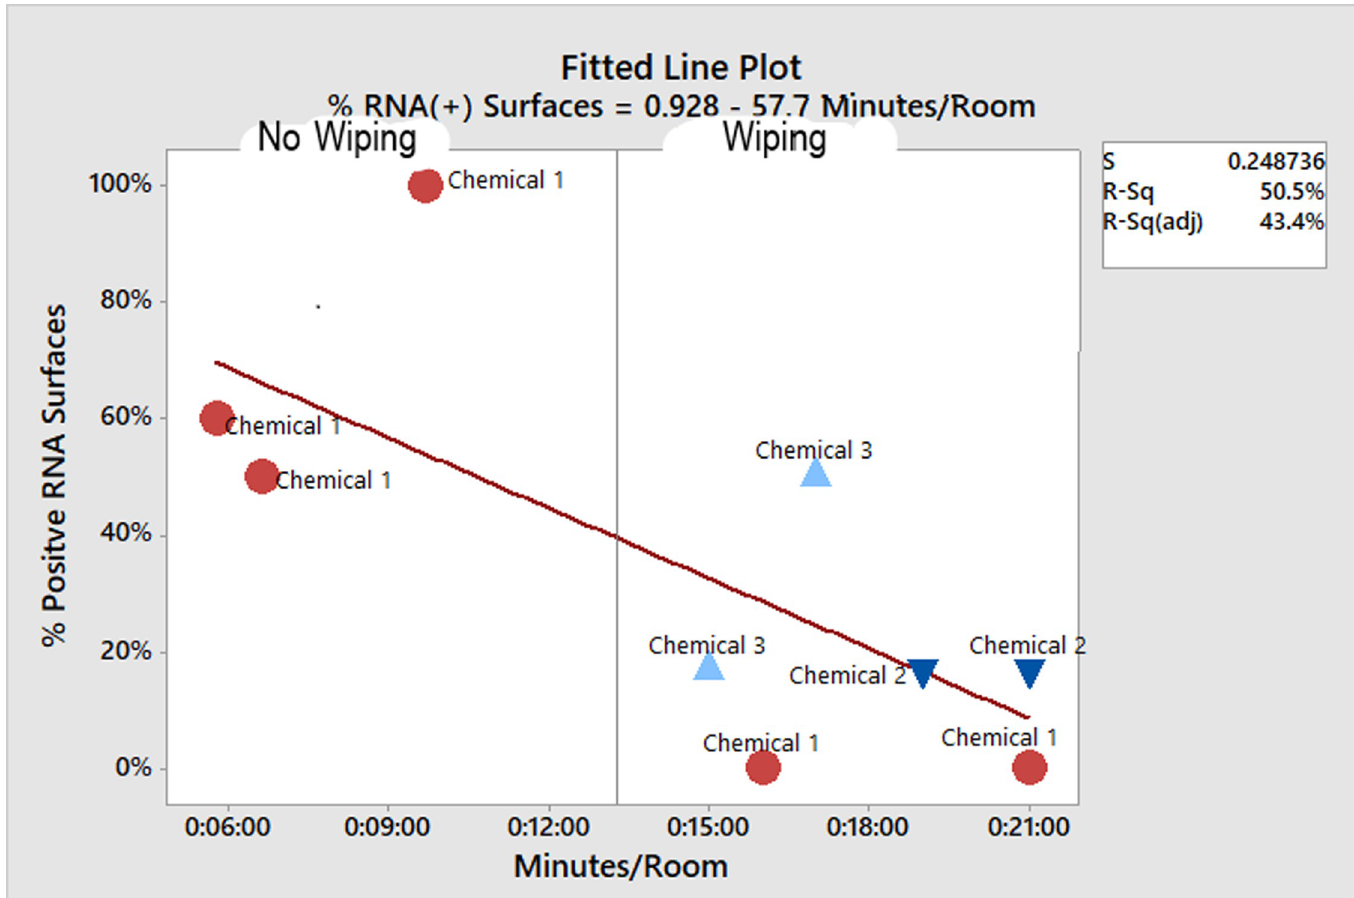
Fig 4. Effect of chemical type and cleaning time on percent of surfaces detected.